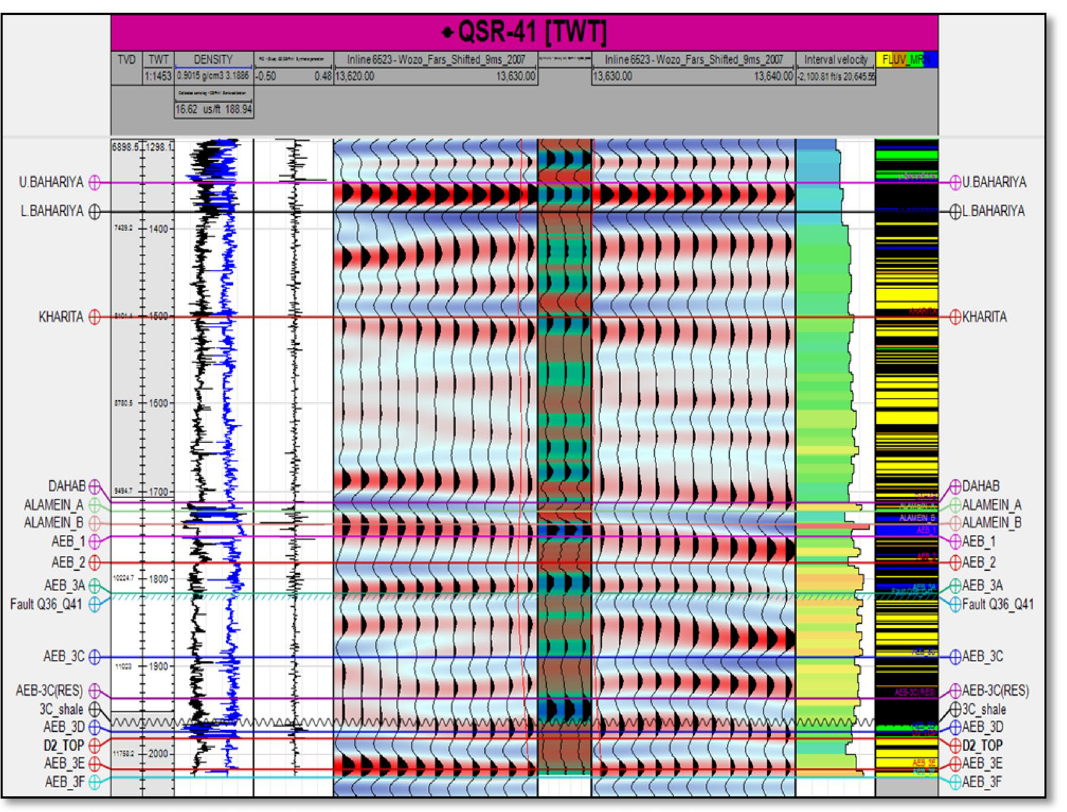
Fig. 12 Synthetic seismogram of well Qasr-41, depth–TWT relationship with linear depth scale. Note that the sandstone is shown by yellow color on the lithology column to